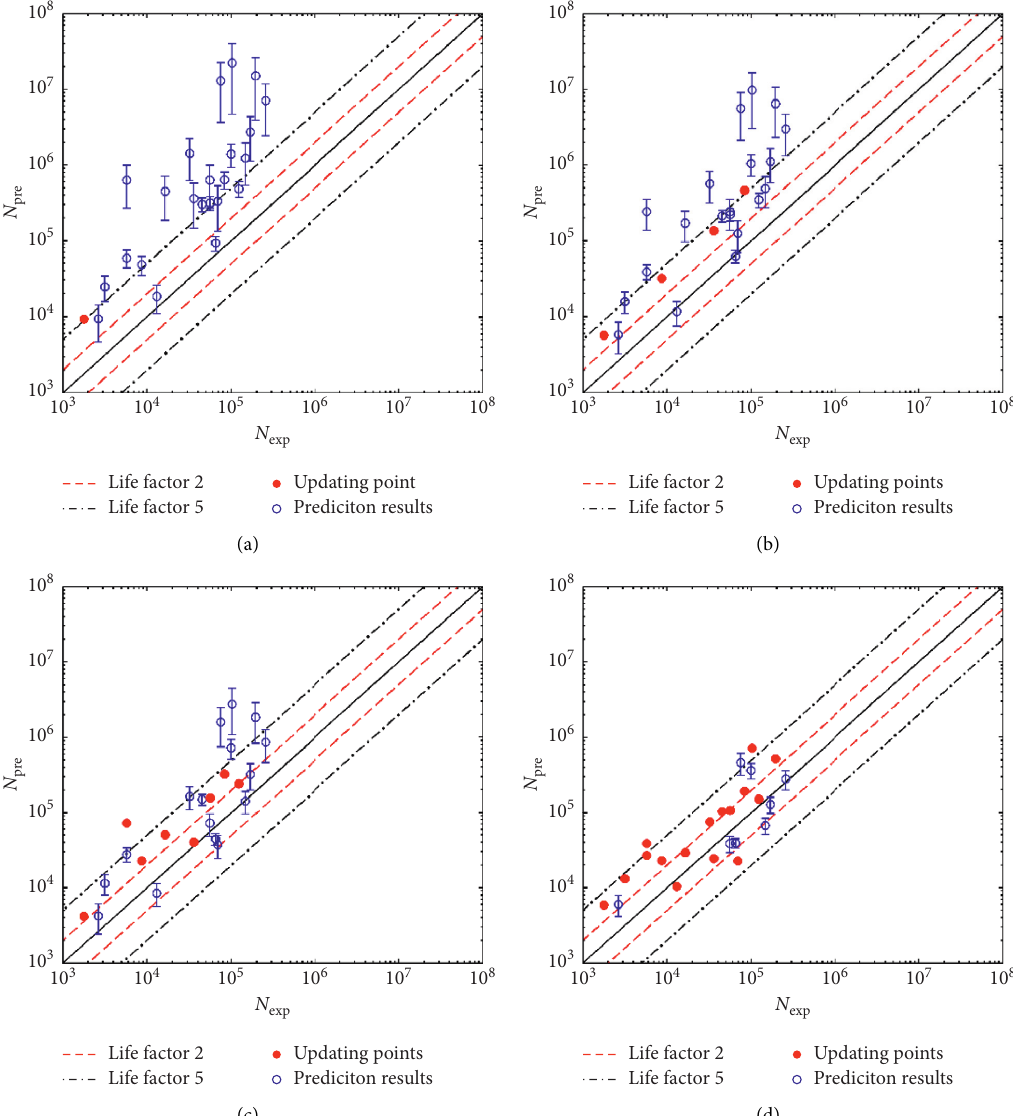
Figure 14: Fatigue life prediction results for 10mm-diameter bars using the model updated with (a) 1 point, (b) 4 points, (c) 8 points, and (d) 16